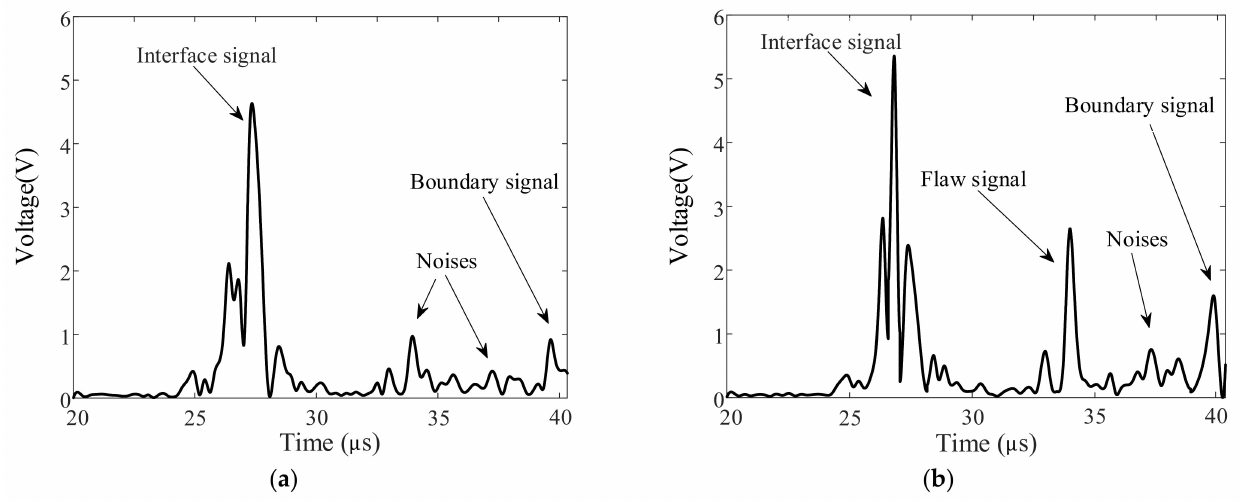
Figure 7. Typical A-wave signals measured using the PIF transducer for ( a ) the reference weld component and ( b ) the weld with a